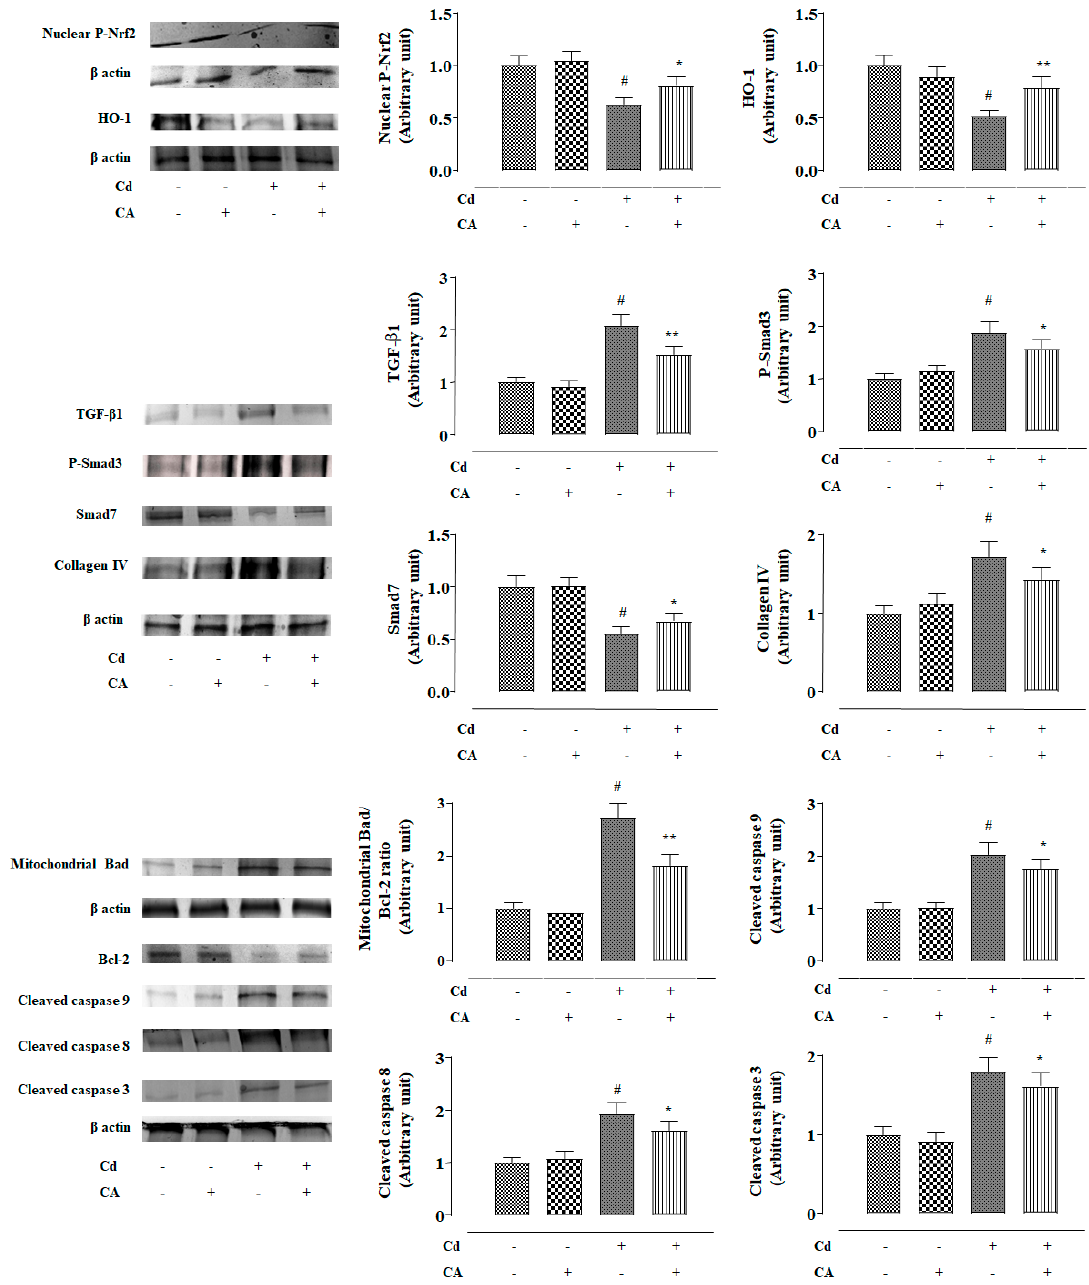
Figure 6. The effects of CdCl 2 and/or CA on signal transduction in mouse kidneys in vivo. The relative band intensities were measured and the intensity of the normal control band was chosen as 1. β -actin served as loading control. Data are represented as mean ± SD, n = 6. # Values significantly ( p < 0.01) differed from the vehicle-treated group. * Values significantly ( p < 0.05) differed from only the CdCl 2 -treated group. ** Values significantly ( p < 0.01) differed from only the CdCl 2 -treated group.